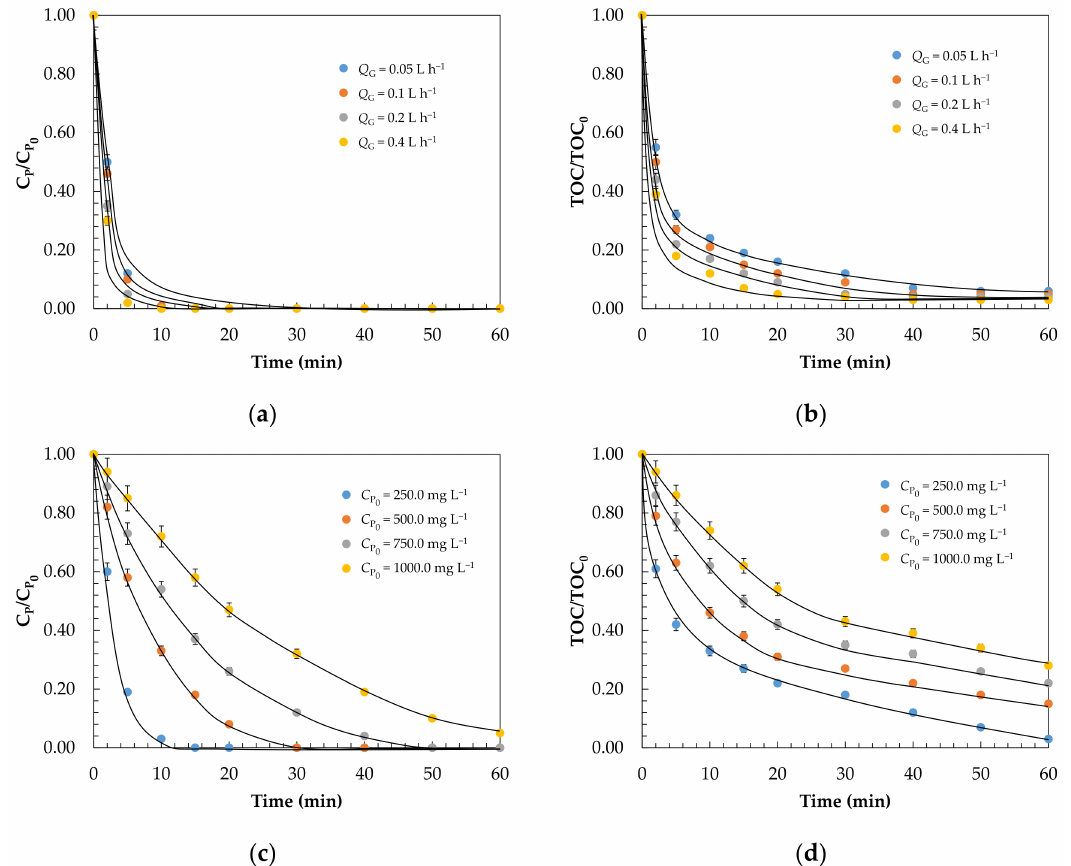
Figure 5. Analysis of C P and TOC concentration profiles during the initial transitory period (t < 70 min) and adjustment to the Ad/Ox kinetic model. Effect of ( a , b ) ozone flow rate 1 and ( c , d ) concentration of the pollutant load 2 . Experi- mental conditions: 1 C P = 250.0 mg L − 1 , P = 2.5 atm, pH = 11.0; C O = 19.0 mg L − 1 , Q L = 12 mL min − 1 , V = 0.14 L; 0 3 ,G − 1 , Q − 1 , Q − 1 , V = 0.14 2 pH = 11.0, P = 2.5 atm; C O 3 ,G = 19.0 mg L L = 12 mL min G = 0.05 L h